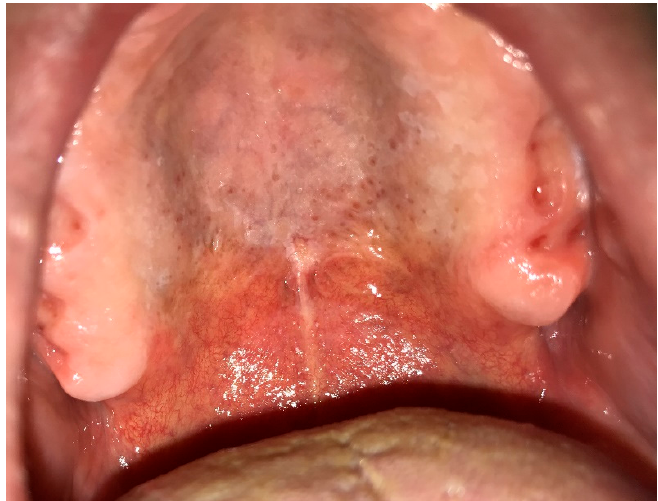
Figure 12. Nicotinic stomatitis on the hard palate.